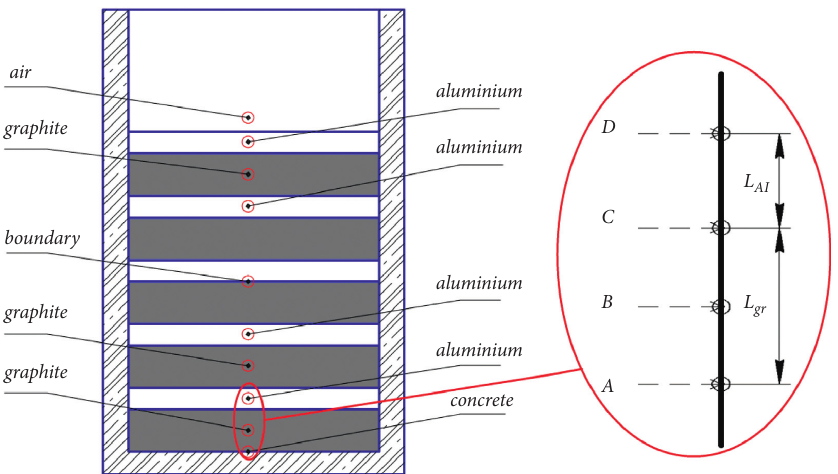
Figure 10: Computational domain